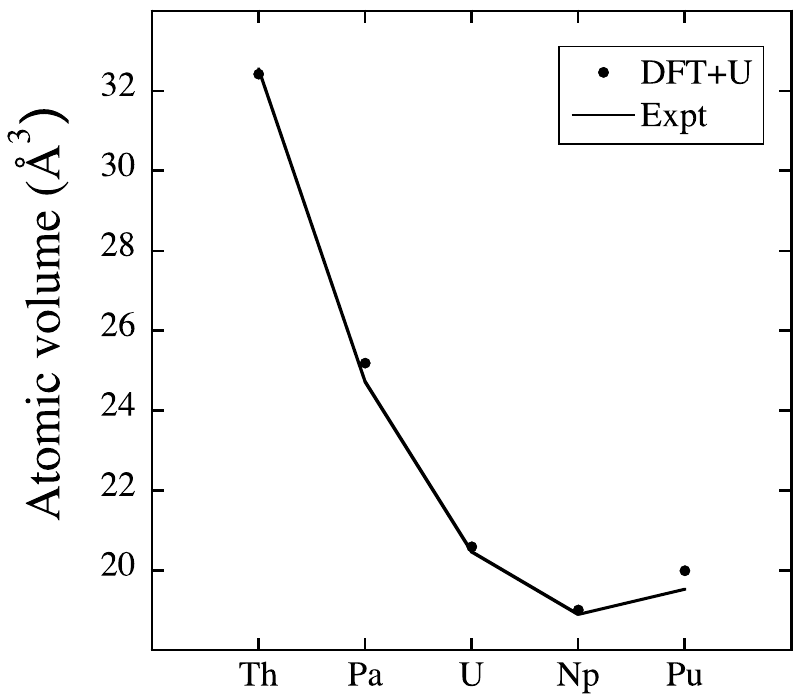
Figure 4. Experimental ( T = 0, see main text) and DFT + U (VASP) atomic volumes (Å 3 ) for the actinides. The calculations include a Hubbard U = 0.4 eV and spin–orbit coupling (not on p states) but no orbital polarization.